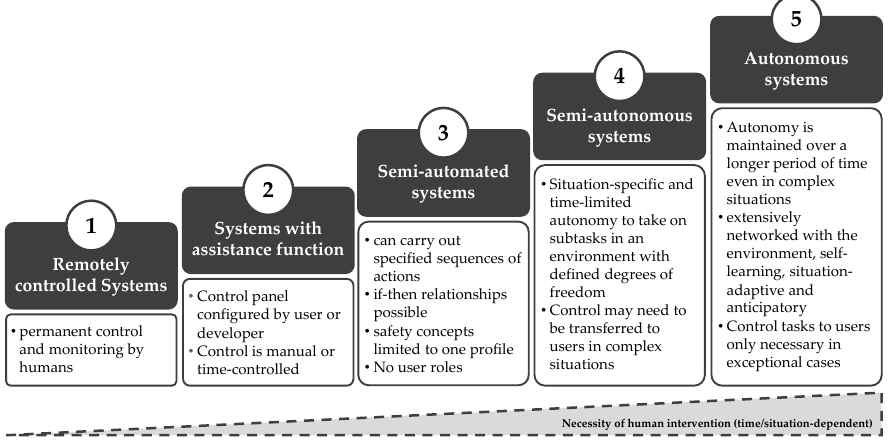
Figure 2. Development stages of technical systems towards autonomous systems according to Dumitrescu et al. [10] (p. 18).